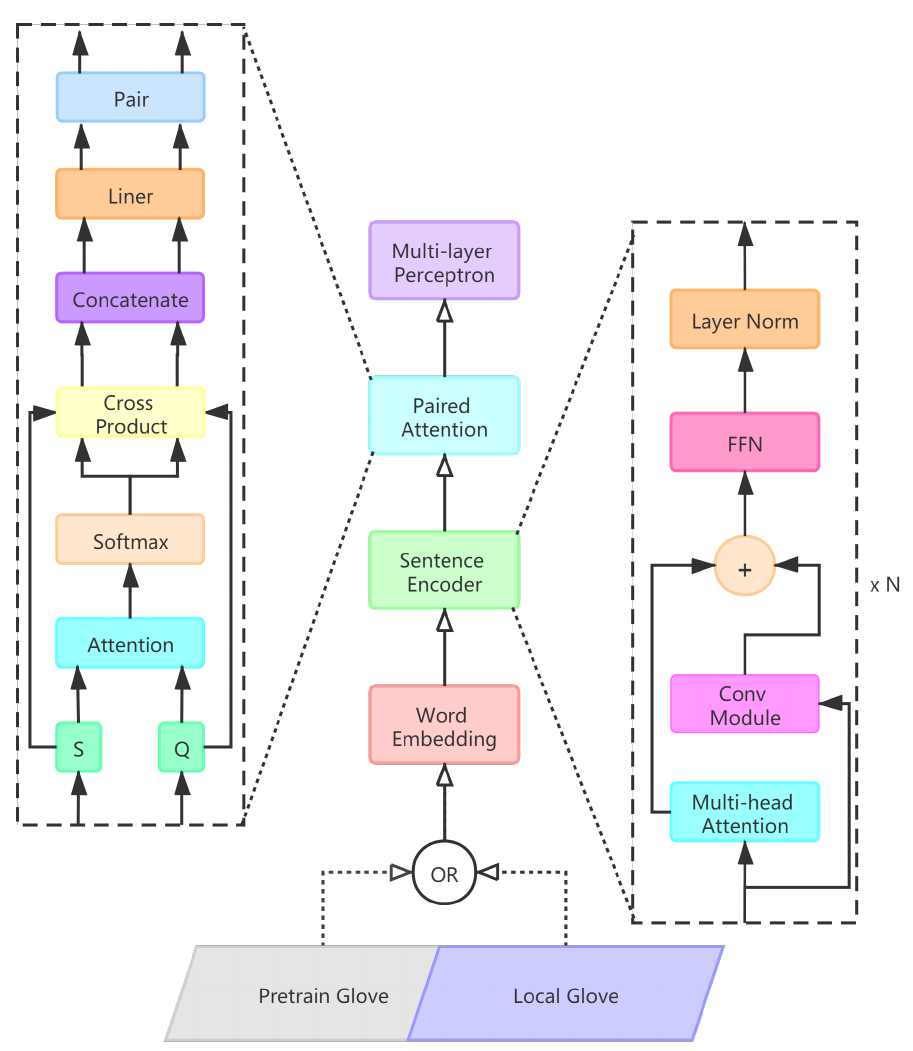
Figure 1. Overall structure of the proposed